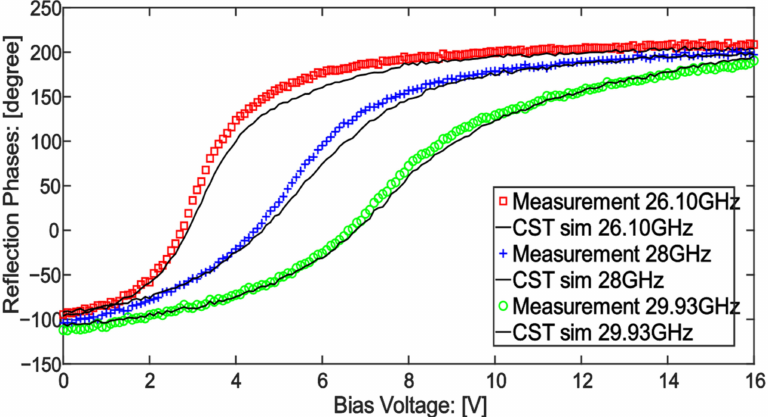
Figure 6. MSRRA measurement and simulation results in marked lines and solid lines; they show a good degree of agreement with each